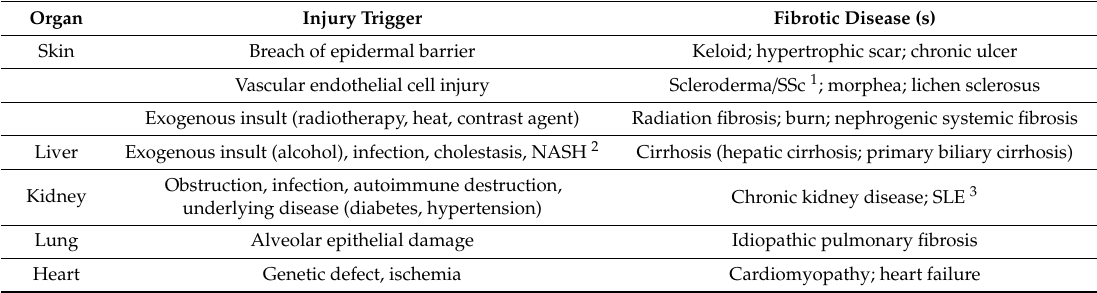
Table 1. Wounding as a trigger of human fibrosing disorders in multiple